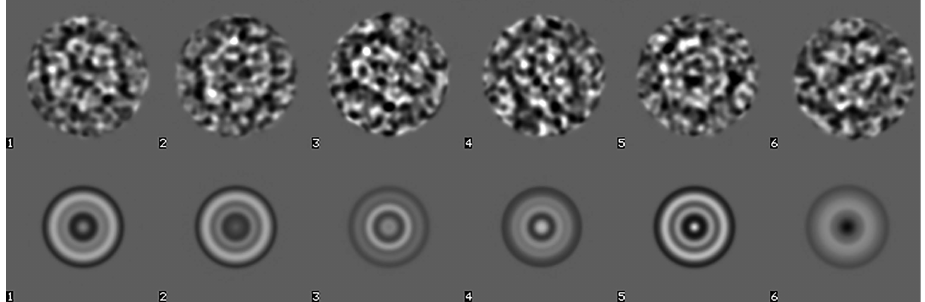
Figure 5 Six manually selected particles (top row) used as templates for an initial competitive particle picking and their rotational averages (bottom row).